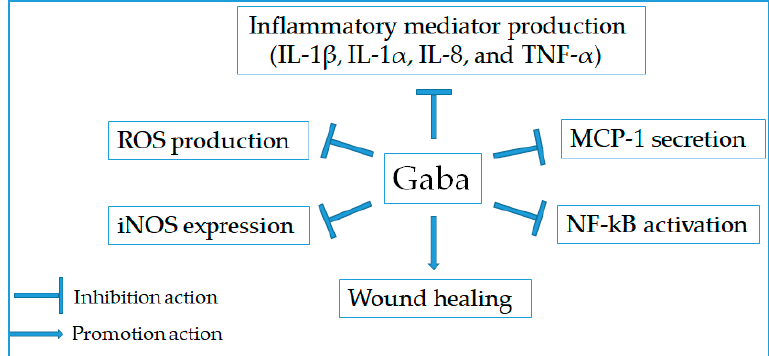
Figure 5. Therapeutic targets for anti-inflammatory activity of Gaba.